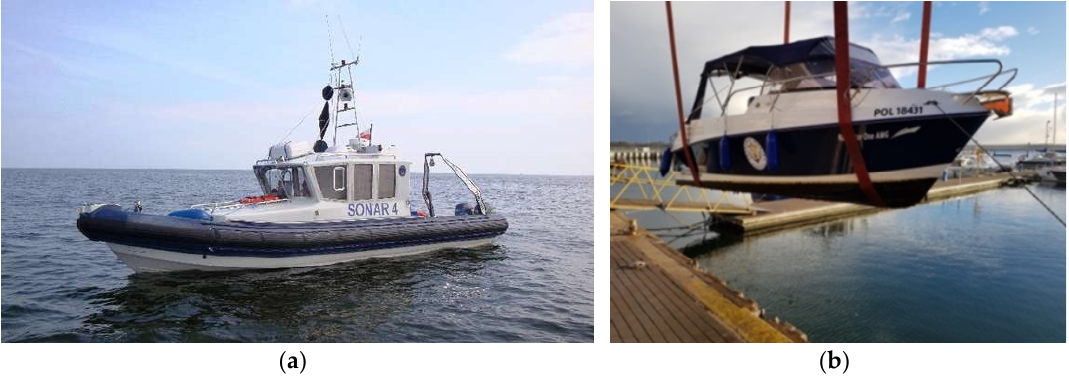
Figure 1. Hydrographic vessels used for surveys in the years of 2010–2015 ( a ) and 2018 [24] ( b ).